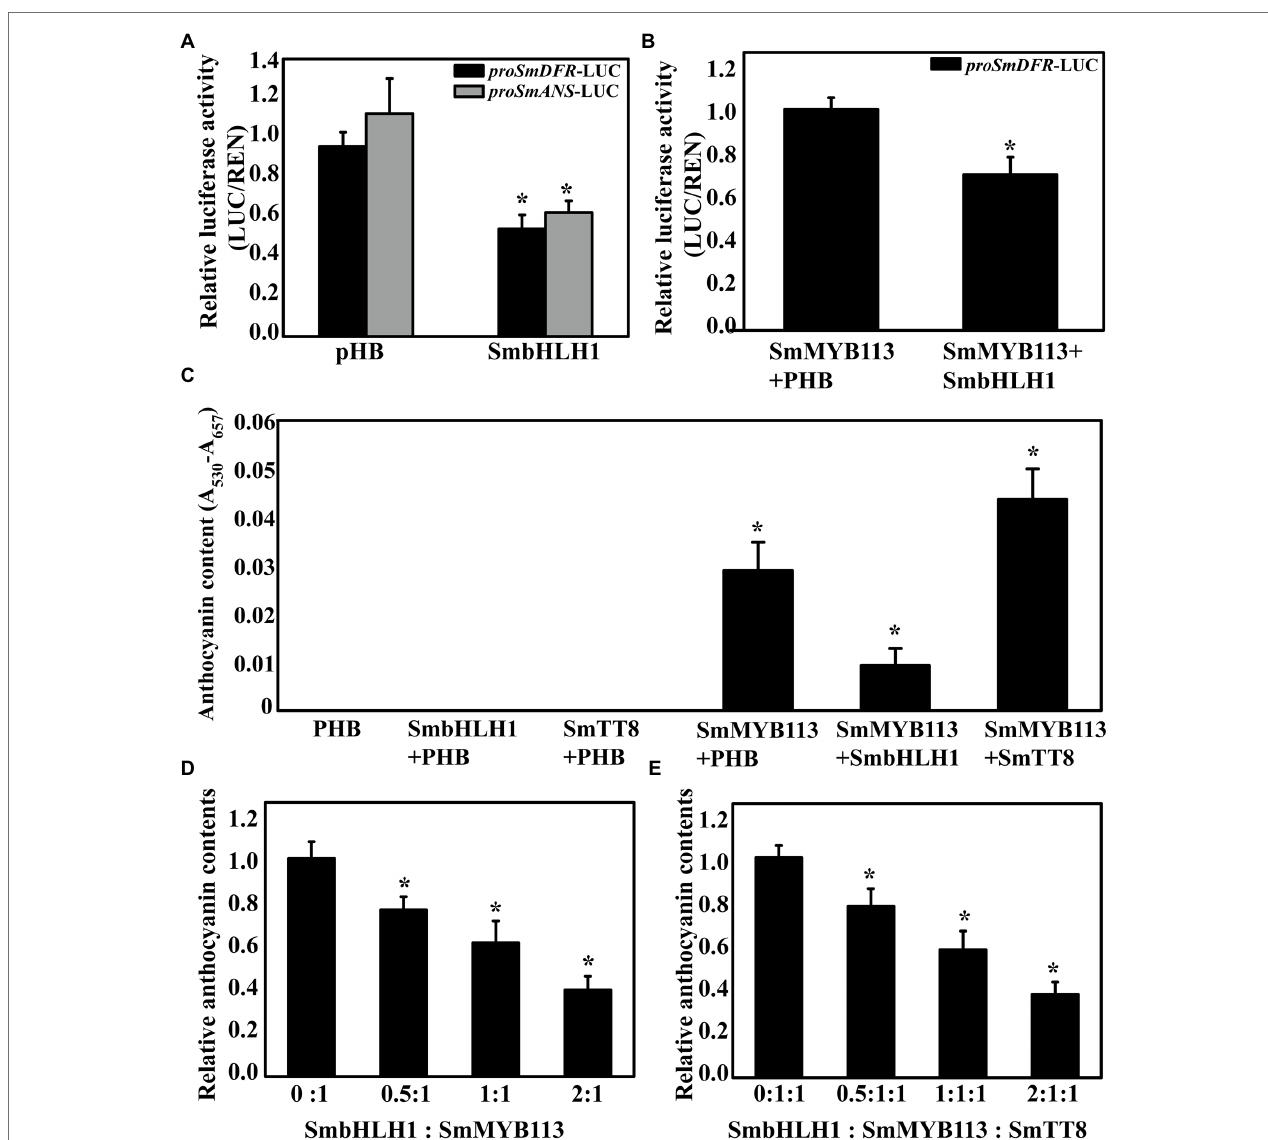
FIGURE 5 | Dual-luciferase and transient analysis of SmbHLH1 on anthocyanin accumulation. (A) Inhibition of the activity of the SmDFR and SmANS gene promoters by SmbHLH1 in transient expression assay in N. benthamiana leaves; (B) SmbHLH1 decreased the ratio of LUC/REN of the SmDFR promoter activated by SmMYB113; and (C) SmbHLH1 inhibited SmMYB113-induced anthocyanin accumulation while SmTT8 enhanced in N. benthamiana leaves. (D,E) The relative anthocyanin contents induced by different proportions of SmbHLH1 : SmMYB113 and SmbHLH1 : SmMYB113 : SmTT8 in infiltrated regions. *Represents significance at p < 0.05 comparing with the